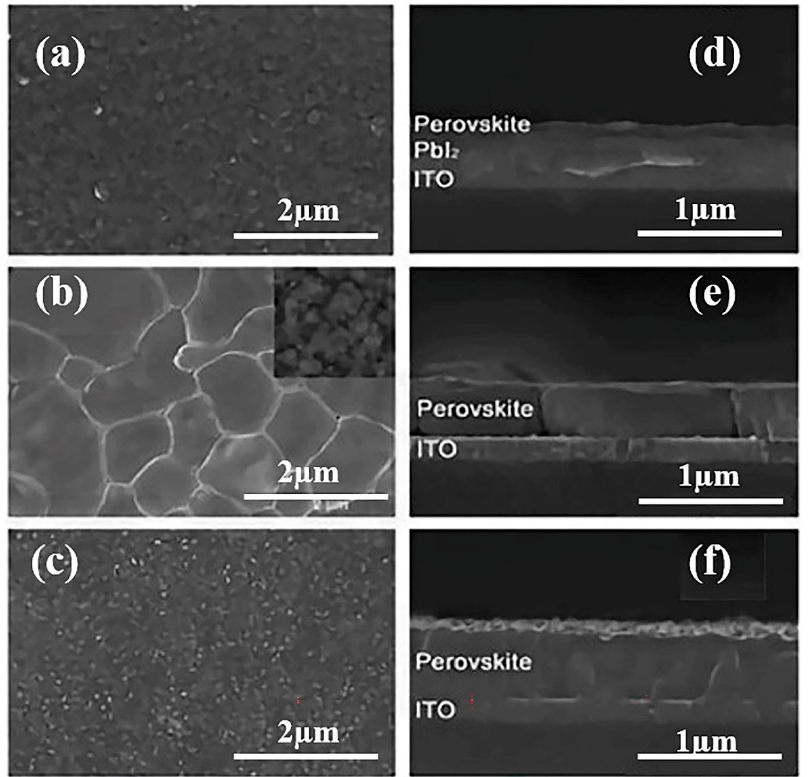
Figure 13. Morphology analysis through the top view ( left column ) and cross-sectional ( right col- umn ) SEM imaging of sequentially evaporated MAPbI films with MAI deposition pressures of 10 − 5 Torr, ( a , d ), 10 − 4 Torr, ( b , e ), and 10 − 3 Torr, ( c , f ) [141]. Copyright 2016 WILEY-VCH VERLAG GMBH & CO.